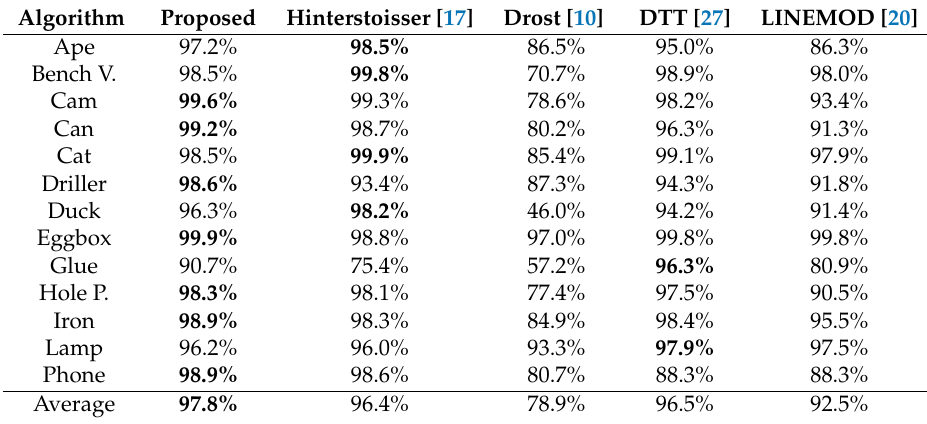
Figure 12. Our detection on ( a ) Ape; ( b ) Benchvise; ( c ) camera of ACCV dataset; ( Left ) image after scene preprocessing. ( Right ) detection result. The green points show the detection result. Table 1. Accuracy of the algorithms on the ACCV dataset of